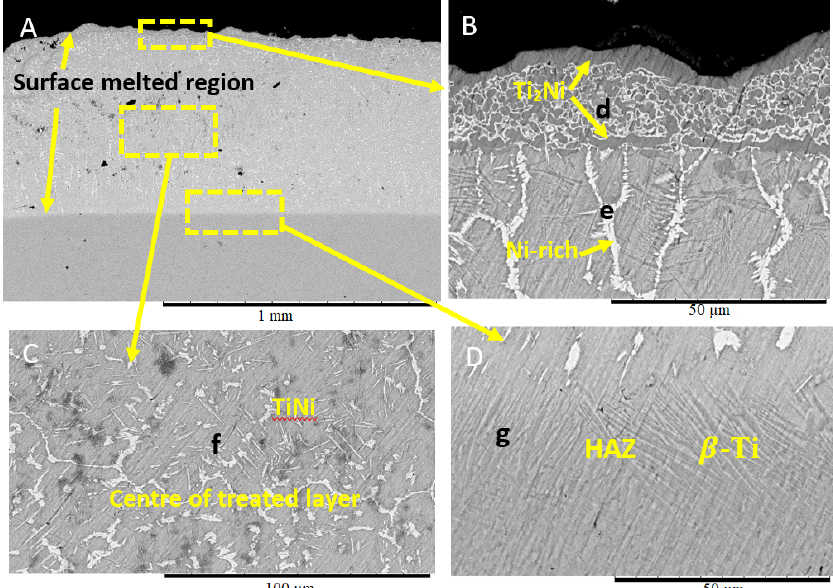
Figure 4. Ti-6Al-4V coated with Ni/Al 2 O 3 + 30 nm diameter TiO 2 particles and melted with Gas Tungsten Arc Welding (GTAW) at 50 A. ( A ) SEM micrograph of the treated surface layer. ( B ) Microstructure at the upper section of the treated layer. ( C ) The microstructure of the middle of the treated layer. ( D ) Microstructure within the HAZ.